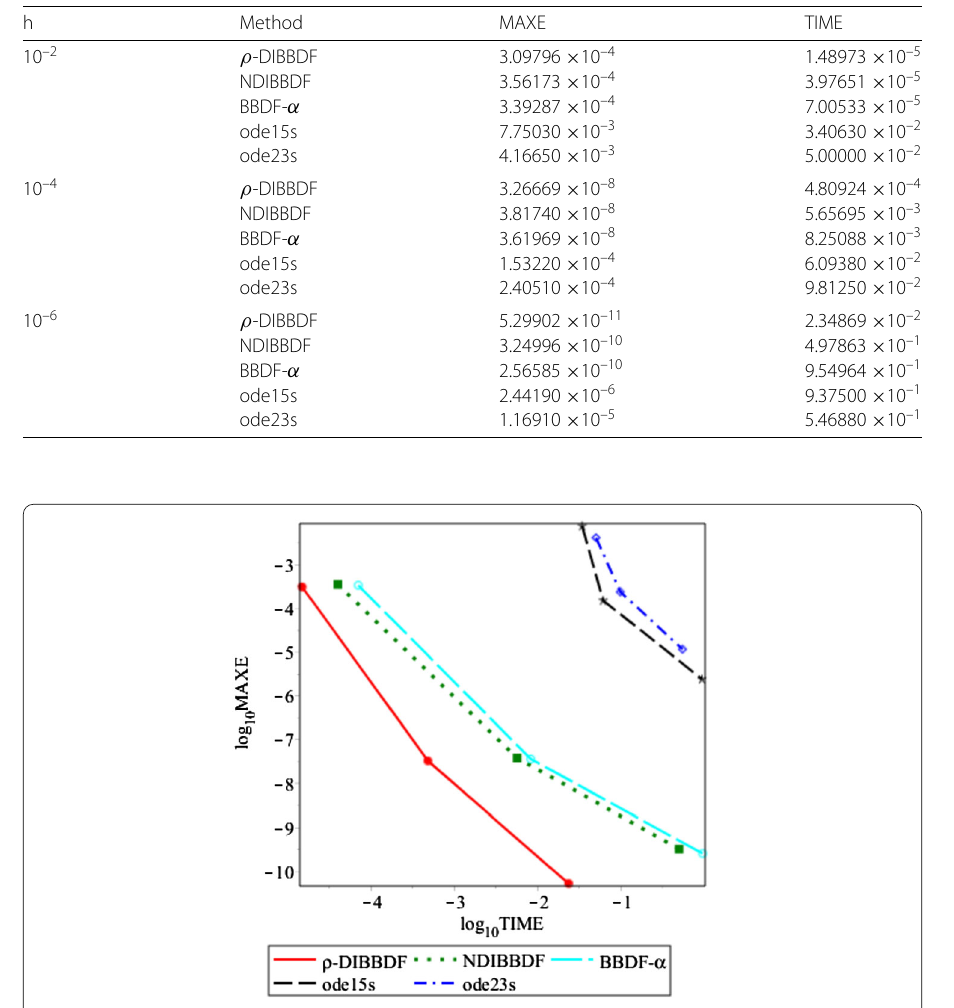
Table 4 Numerical results for concentration of drug in Model A